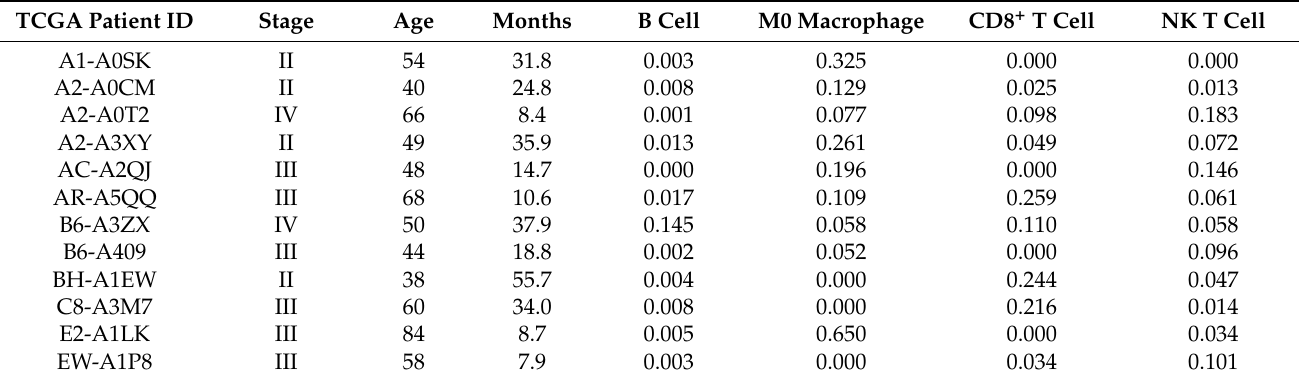
Table 2. Clinical and critical immune cell composition (identified via XAI) from bulk RNA-seq data of TNBC patients that survived for less than 5 years.